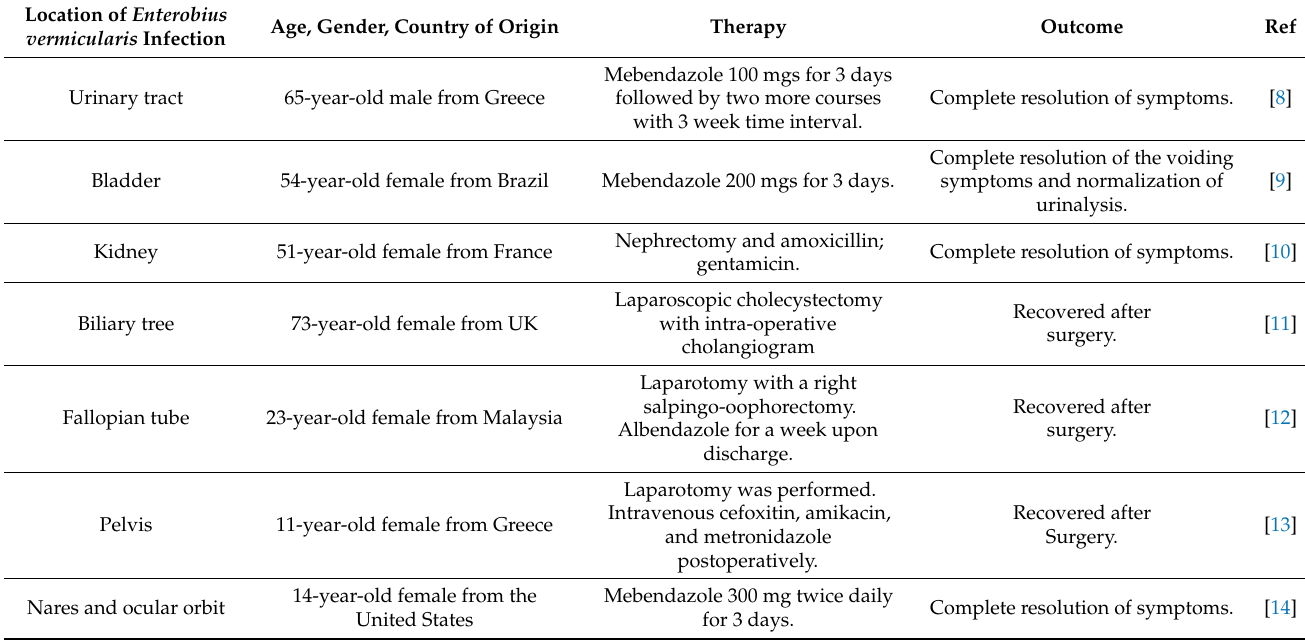
Table 1. Clinical cases described in the text. All cases did not report any travel